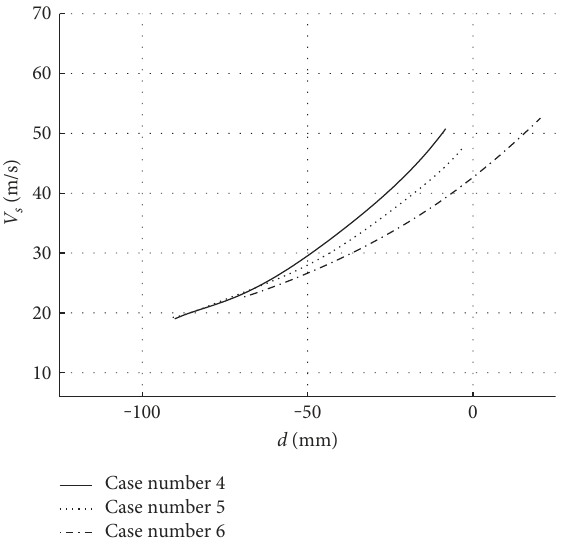
Figure 9: Slip velocity pro fi les for cases #4, #5, and #6 as a function of the droplet horizontal distance to the airfoil leading edge.